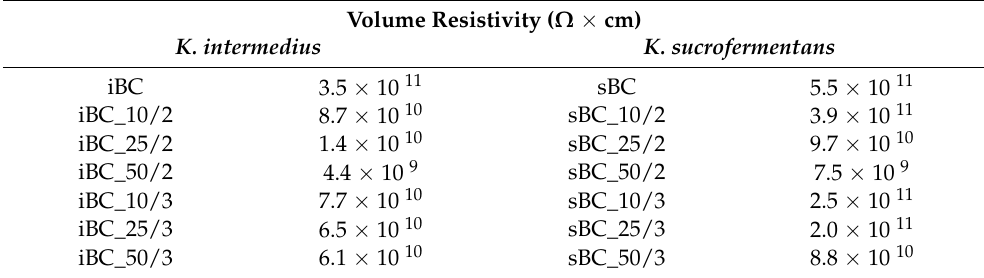
Table 5. Volume resistivity of the obtained BC and GO/BC